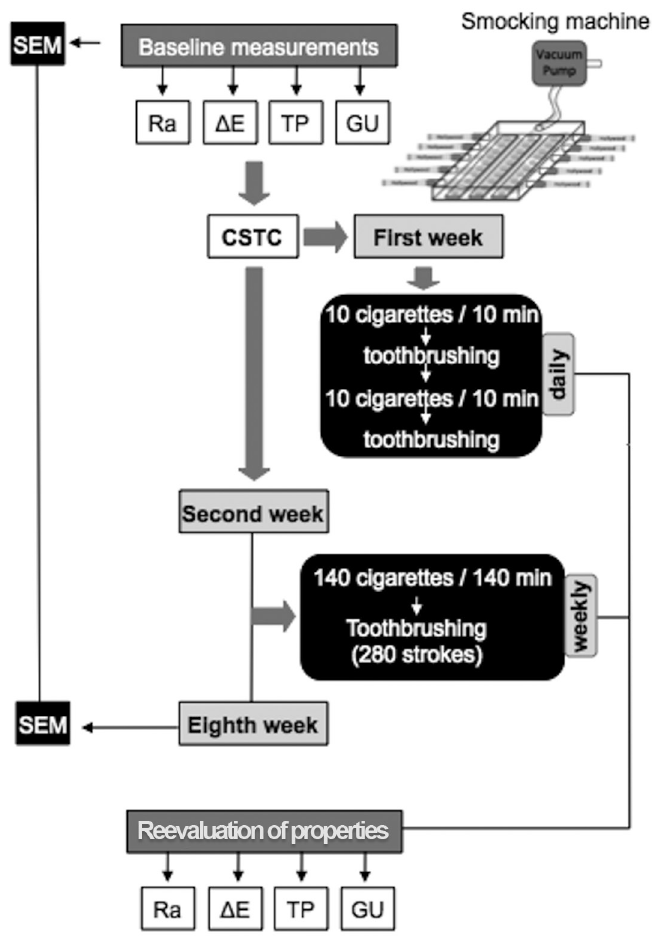
Figure 2- Flowchart of the